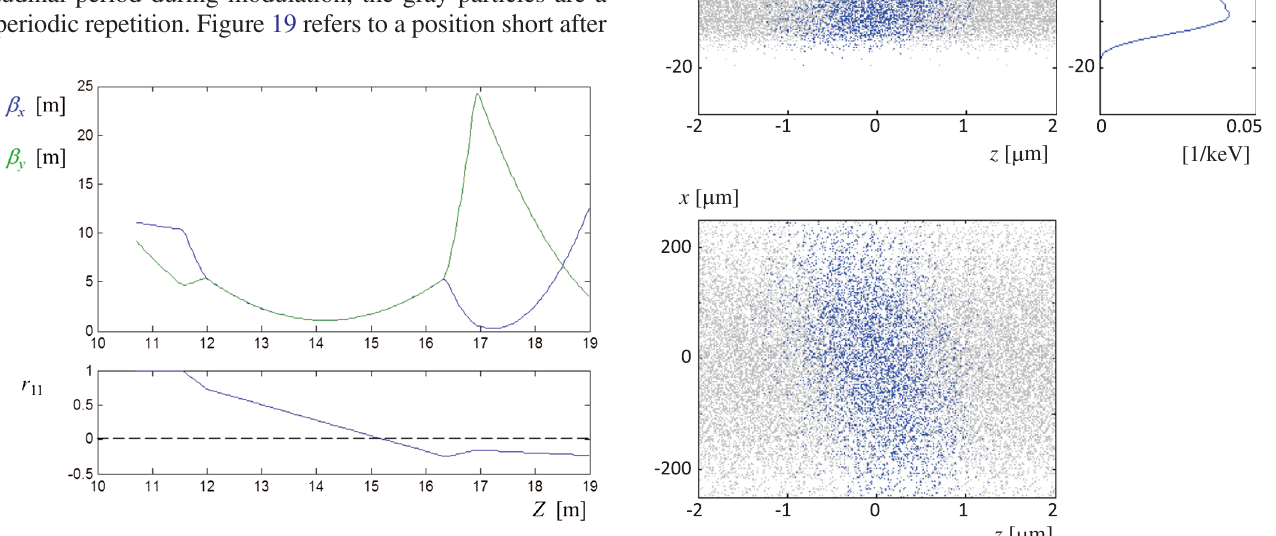
FIG. 19. Application C: longitudinal phase space ð Δ E ; z Þ , top view ð x; z Þ and energy spectrum for the position 11 m, short after the